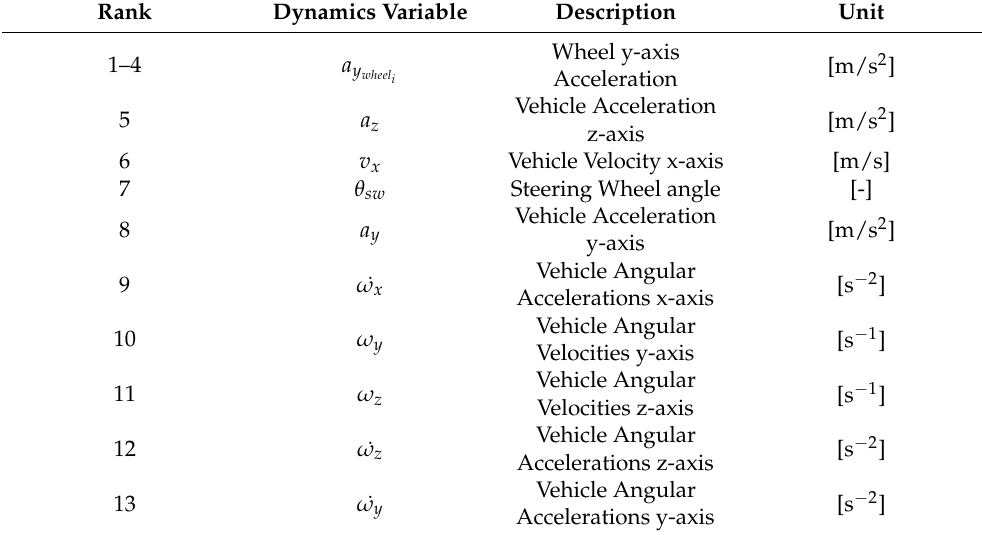
Table 4. Final list of input